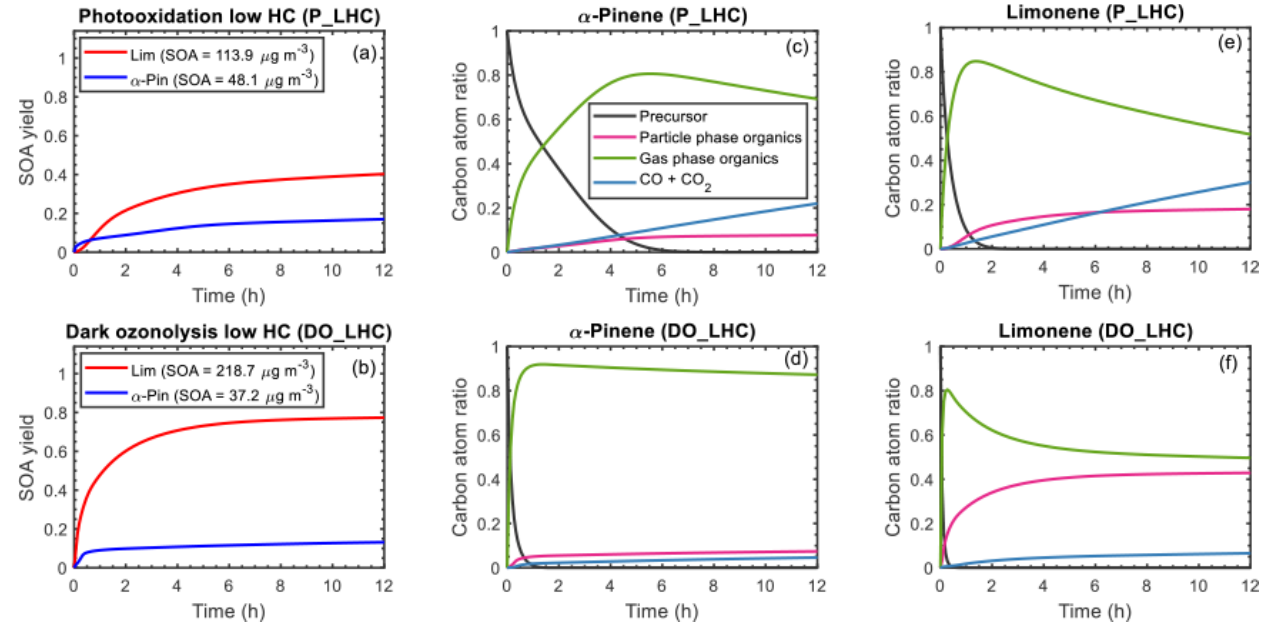
Figure 7. Simulated SOA yield (a, b) and carbon budget (c–f) as a function of time for α -pinene and limonene during photooxidation (a, c, e) and dark ozonolysis (b, d, f) . The SOA yield curve for α -pinene is represented by a blue line; limonene is represented by a red line. For the carbon budget plots, the mixing ratios of the precursor (black line), particle-phase organics (magenta line), gas-phase organics (green line), and CO + CO 2 (blue line) are expressed as carbon atom ratios (ppbC / initial precursor in ppbC; ppbC signifies parts per billion carbon). The results shown are for the low hydrocarbon mixing ratio (50ppb)